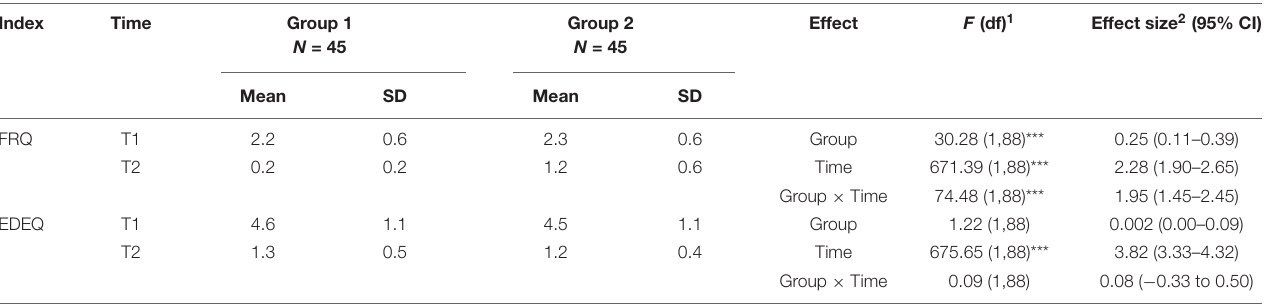
TABLE 2 | Change in FRQ and EDEQ scores in both groups (means, SD, p , effect size, and 95% CI).